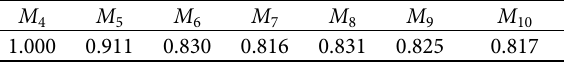
Table 4. Values of factor M i , taking into account the month when measurement is performed (Aavik 2003)